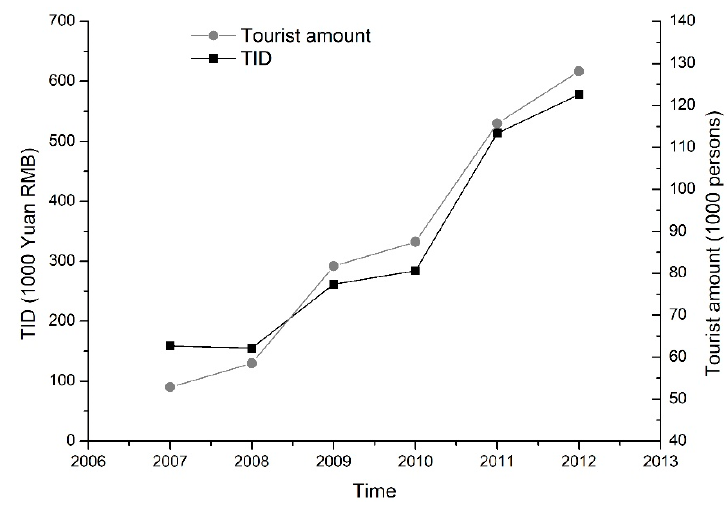
Figure 5. the tourist number and TID change from 2007 to 2012. Figure 5. The tourist number and TID change from 2007 to